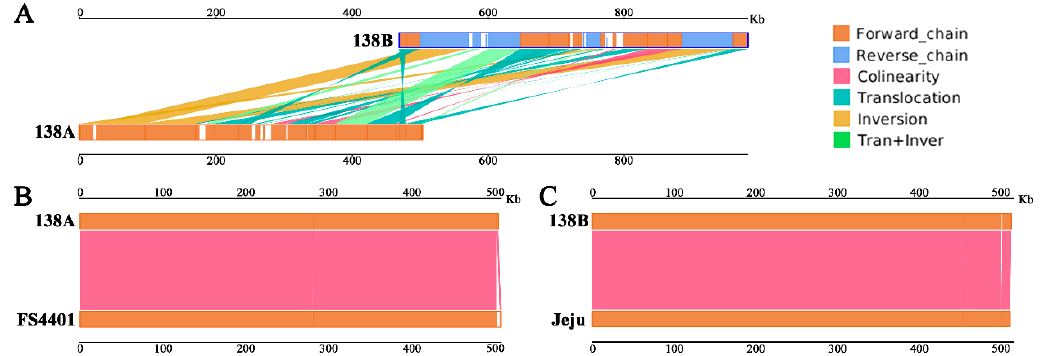
Figure 2. Mitochondrial genome syntenic sequence analysis. ( A ) Syntenic sequence analysis of 138A and 138B; ( B ) syntenic sequence analysis of 138A and FS4401; ( C ) syntenic sequence analysis of 138B and Jeju. The upper and lower bars in each figure represented the mitochondrial genomes. Dark-orange and blue regions in each bar represented the forward and reverse direction of the aligned genome, respectively. White regions in each bar represent the sequences that could not be aligned to the other genome. Lines between the two bars indicated the syntenic types and locations: magenta, blue-green, dark yellow, and light-green represent for collinear, translocation, inversion, and tran + inver, respectively.